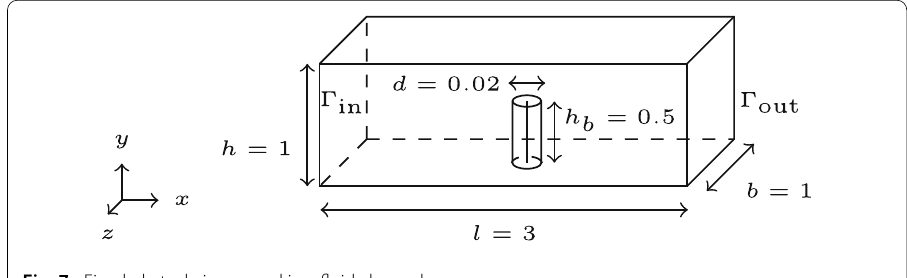
Fig. 7 Fixed obstacle immersed in a fluid channel